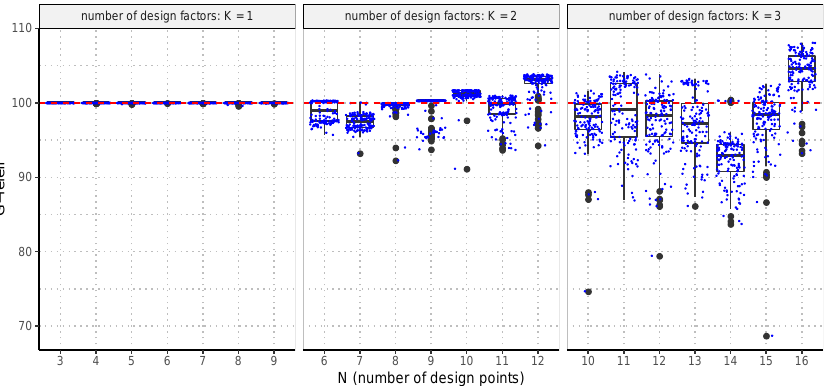
Figure 1. Distributions of G -PSO design efficiencies relative to the published GA designs for K = 1,2,3 design